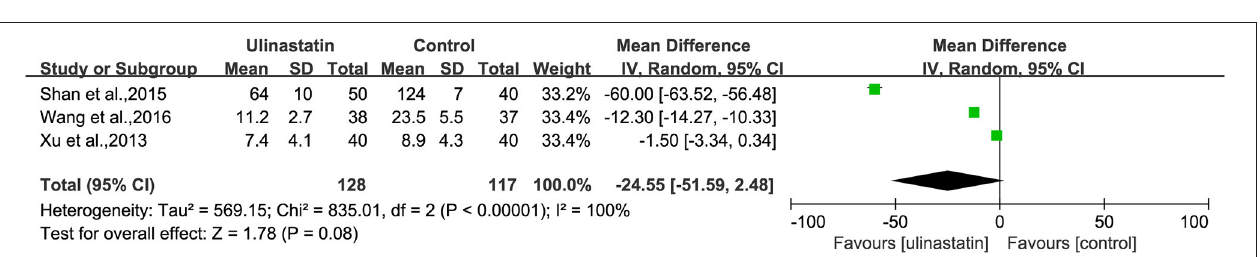
FIGURE 9 | Forest plot: Comparing plasma C-reactive protein (CRP) of patients receiving ulinastatin vs. control.